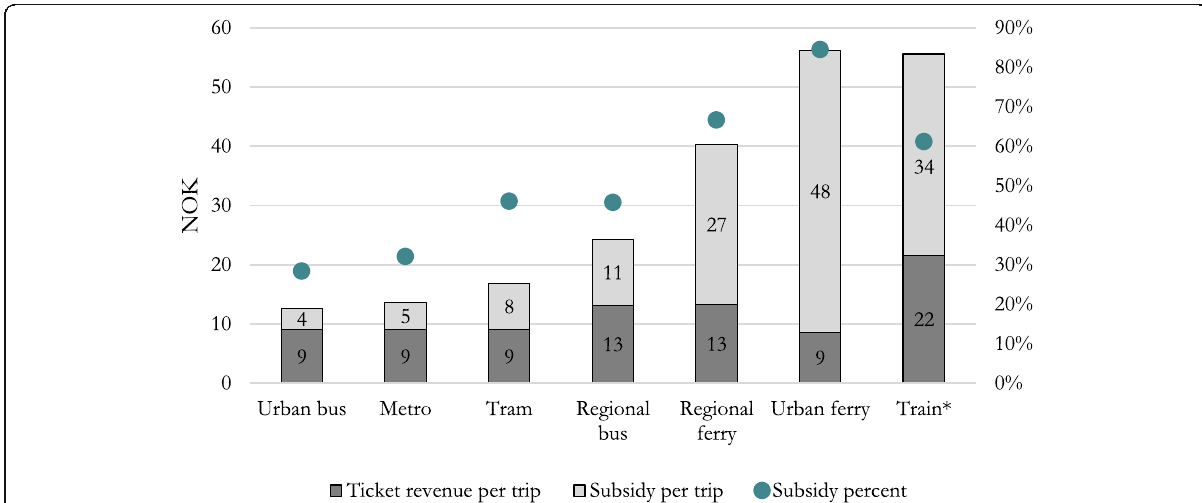
Fig. 4 Ticket revenue and subsidy per unlinked passenger trip in NOKs (left axis) and subsidy as share of total revenue in percent (right axis). Source: Ruter annual report 2017 and for train subsidies Nore et al. [37]. Train is marked by * to indicate uncertainty, especially of subsidy levels. The raw data behind the train column is of low quality. The presented estimate is therefore made conservatively. It is likely to be